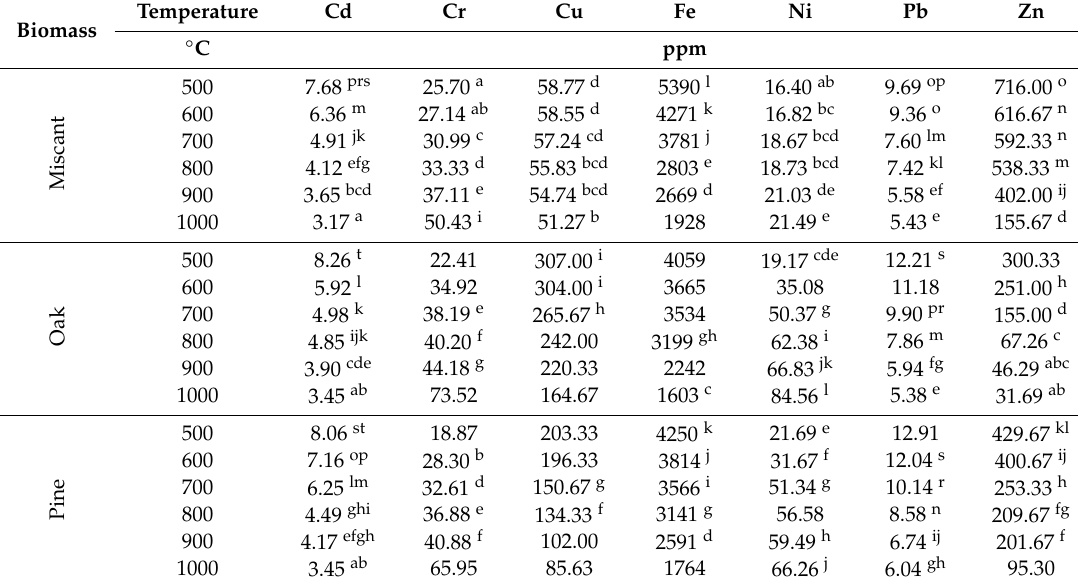
Table 4. Results of detailed comparisons of mean combinations of biomass and temperature with the Tukey test at the significance level of